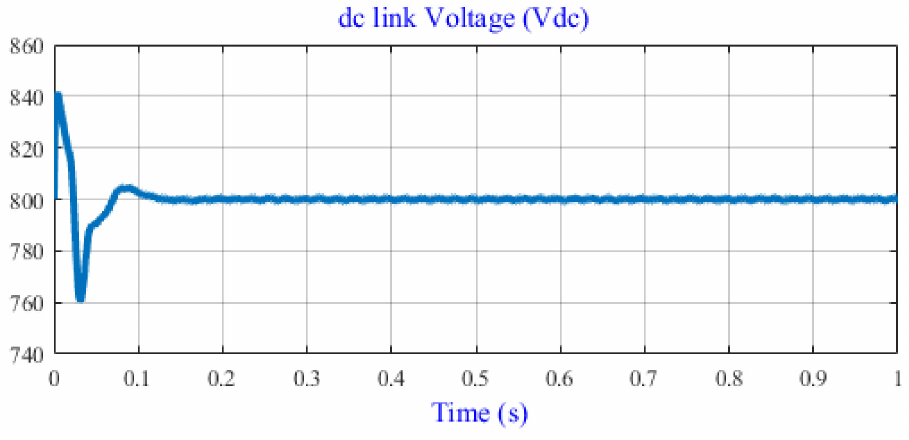
Figure 13. DC-link voltage of the PVPP.